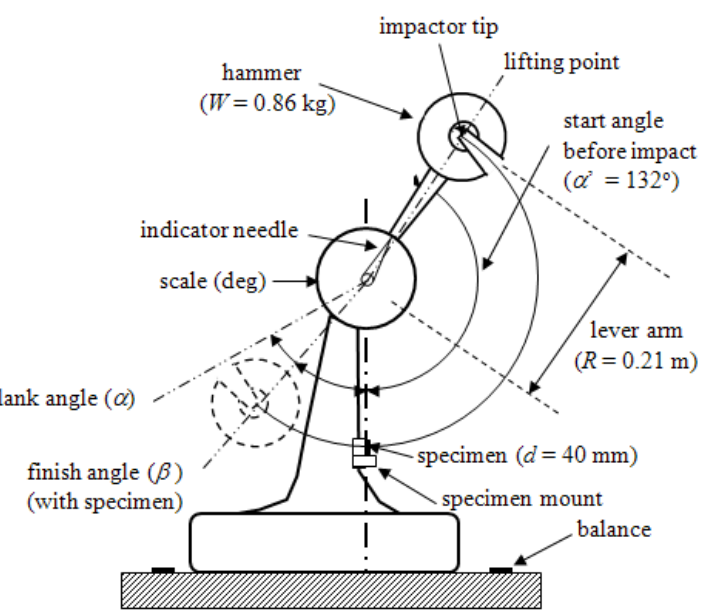
Figure 4. Schematic of the Charpy impact machine (Shimadzu Corporation No.51735, Tokyo, Japan) taken from Faudree, Nishi, Gruskiewicz, Salvia (2018) [51]. Angles α α νδ β are exaggerated for clarity. Here, E , W , R , β , α , and α (cid:48) are: impact fracture energy (kJ); hammer mass (kg); length (m) of hammer weight point from rolling center; maximum angle after impact (Radians); start angle before impact ( a = 2.3 Radians or 132 ◦ ); and maximum angle of blank test, respectively. Angles are read by mechanical indicator needle in Figure